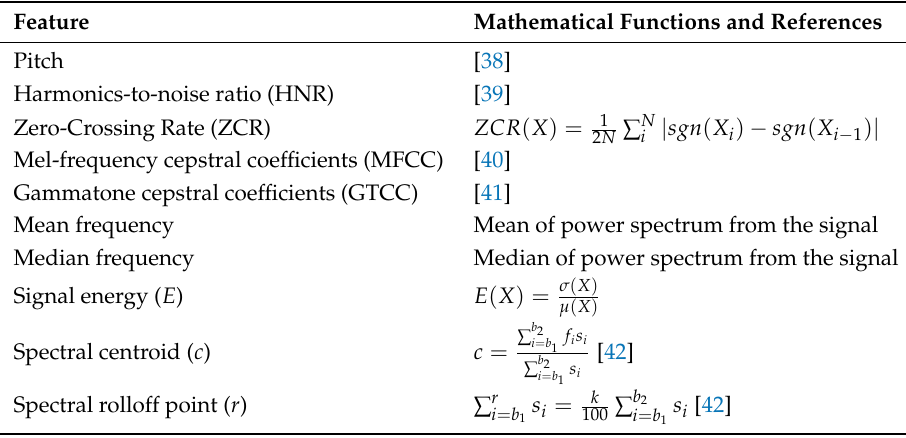
Table 1. List of features utilized in this